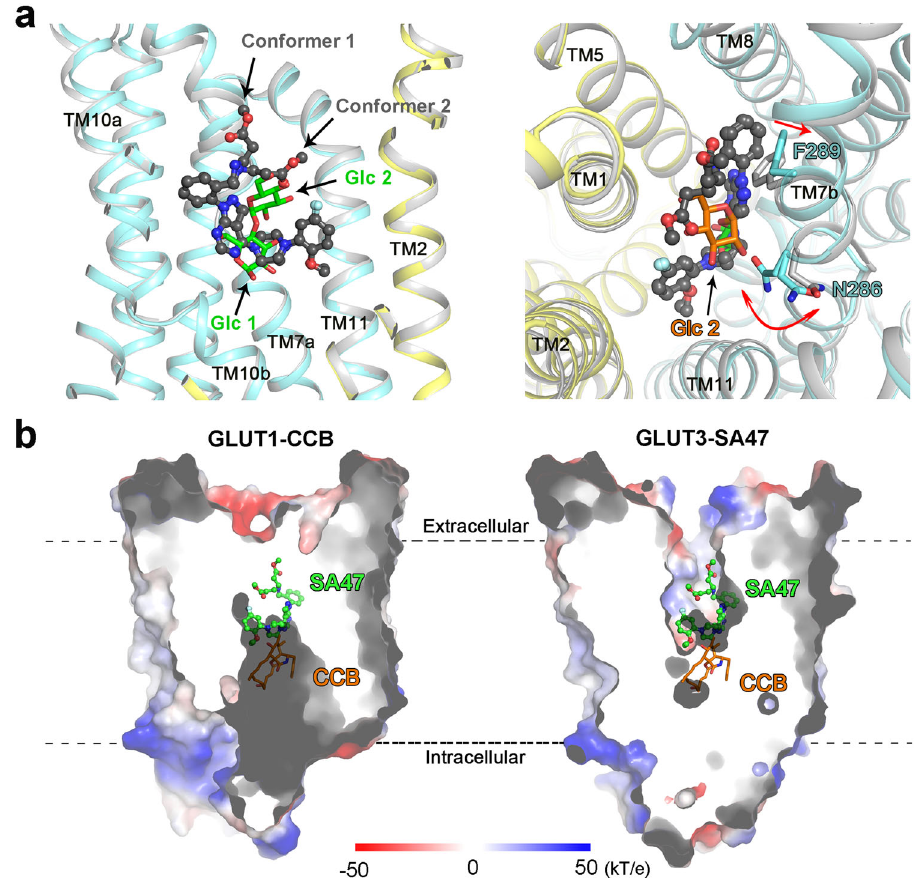
Fig. 5 Structural comparison of different GLUT-inhibitor complexes. a Structural comparison of GLUT3 bound to SA47 and maltose. Left: The NTD and CTD of GLUT3-SA47 were colored yellow and cyan, respectively. GLUT3-maltose structure (PDB code: 4ZWC) was colored gray. Despite the much larger size of SA47 than maltose, the overall structure of GLUT3 remains nearly unchanged in the presence of these two inhibitors. The SA47 was shown as ball- and-sticks and colored gray. The maltose was shown as stick and colored green. Glc1: the fi rst glucose unit; Glc2: the second glucose unit. Right: Residue shifts of TM7b upon SA47 binding. Phe289 and Asn286 on TM7b undergo minor shifts between the two structures. Shown here is an extracellular view of the superimposed structures of GLUT3 bound to SA47 (domain colored) and maltose (gray, PDB code: 4ZWC). The glc2 moiety of maltose is highlighted by colored orange. b Structural comparison of the outward-facing GLUT3-SA47 and inward-facing GLUT1-CCB. SA47 and CCB were positioned based on overall structural superposition of GLUT1-CCB (PDB code: 5EQI) and The model was rebuilt in COOT 45 and re fi ned with PHENIX 46 . Data collection and structure re fi nement statistics are summarized in Supplementary Table S1. Preparation of liposomes and proteoliposomes . E. coli polar lipids (Avanti) were dissolved, dried, and resuspended to a fi nal concentration of 20mg/ml with the